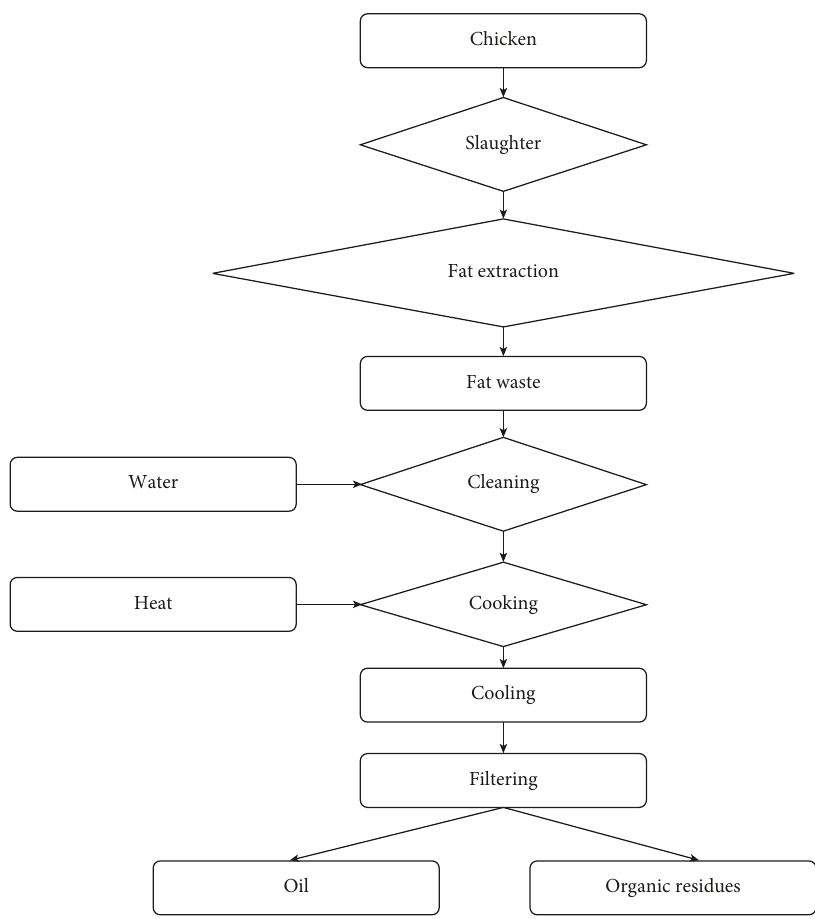
Figure 2: Chicken oil extraction